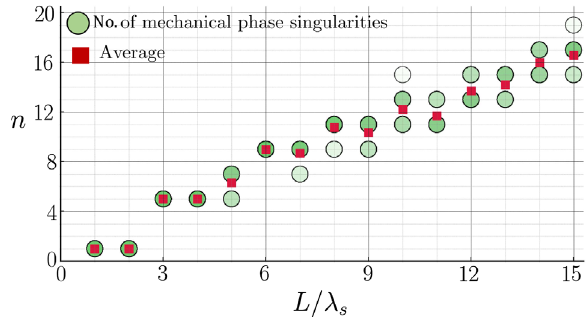
FIG. 7. Number of mechanical phase singularities for a clock- wise rotating spiral in a heart muscle with anisotropic fiber architecture (fibers are along the x axis) as a function of tissue size and tissue size to spiral wavelength ratio L= λ . Different s vertical circles show the different numbers of phase singularities observed in one period. The intensity of the color in each circle exhibits the frequency of occurrence of that number of phase 15 ) during one period, 15, singularities. For instance, for ( L= λ s ¼ 17, and 19 phase singularities are observed. The color density of the circles shows that most of the time there are 17 phase singularities in the domain. The red squares show the average number of singularities during one period.